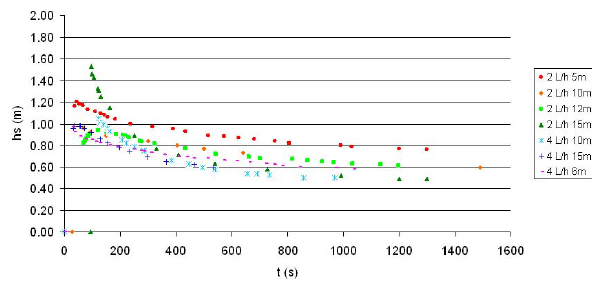
Fig. 4. Evolution of pressure in the soil around the emitter outlet ( h s ) as a function of time.